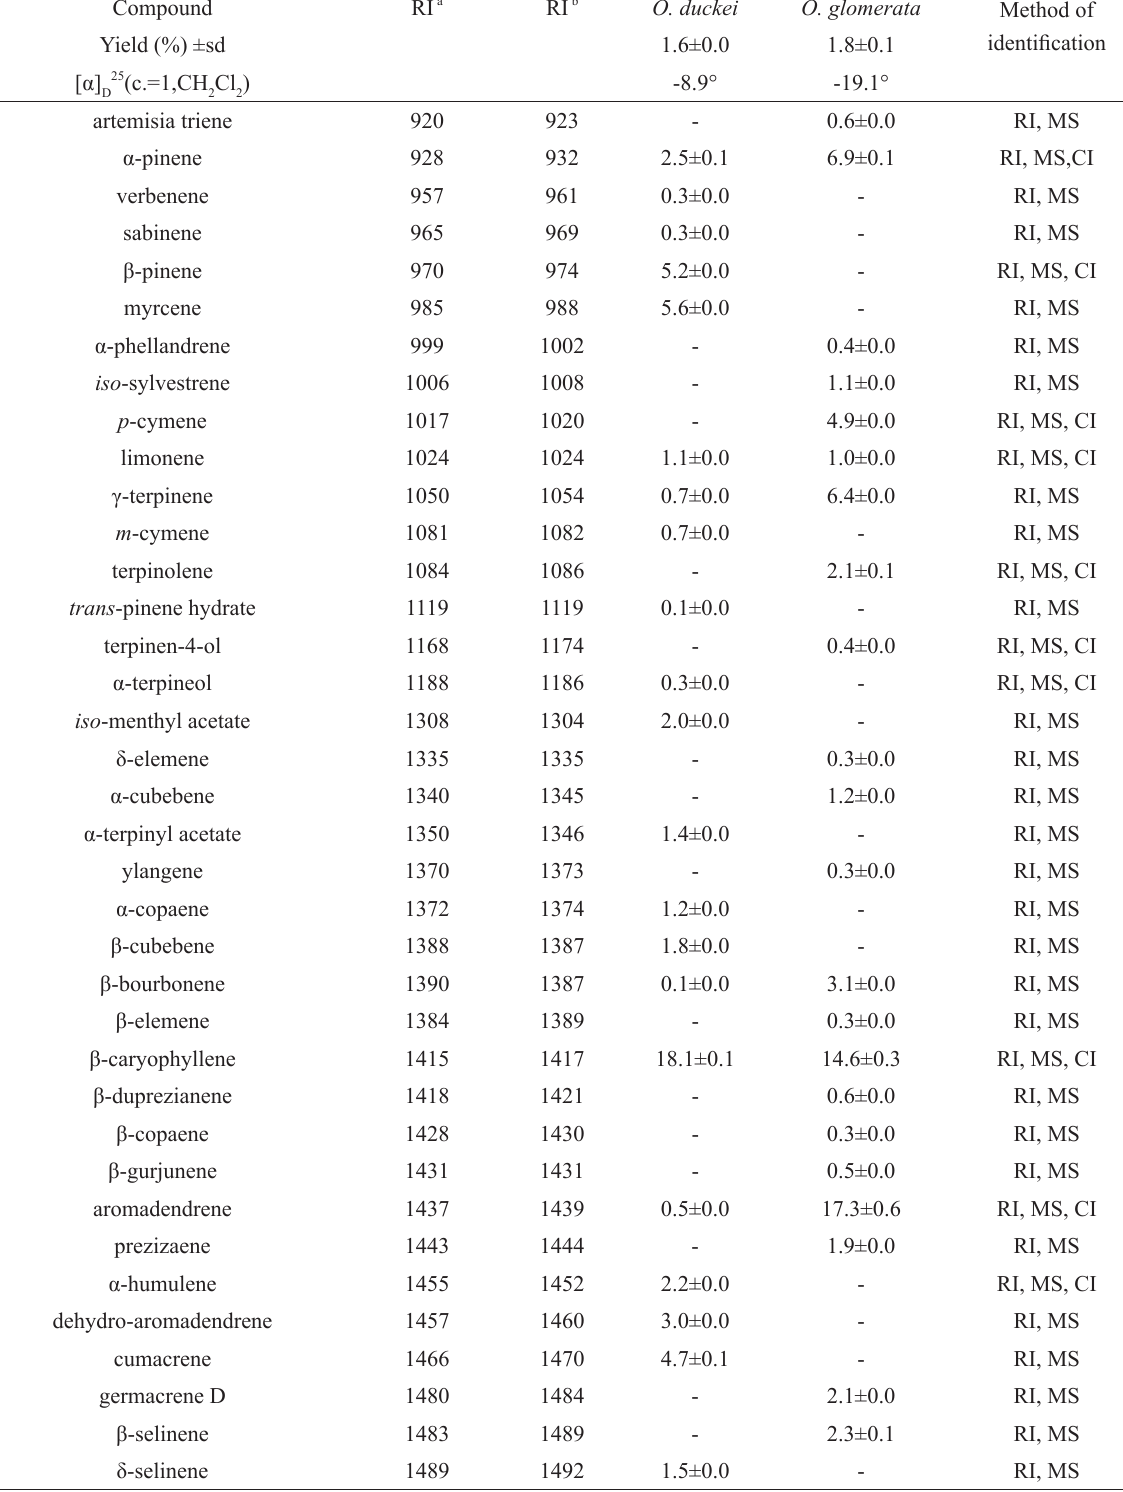
Percentage composition, yield and optical rotation of essential oils from O. duckei and O. glomerata .